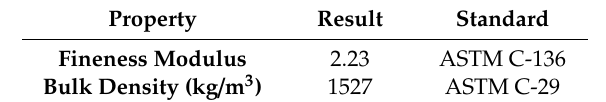
Table 3. Physical properties of fine aggregate.